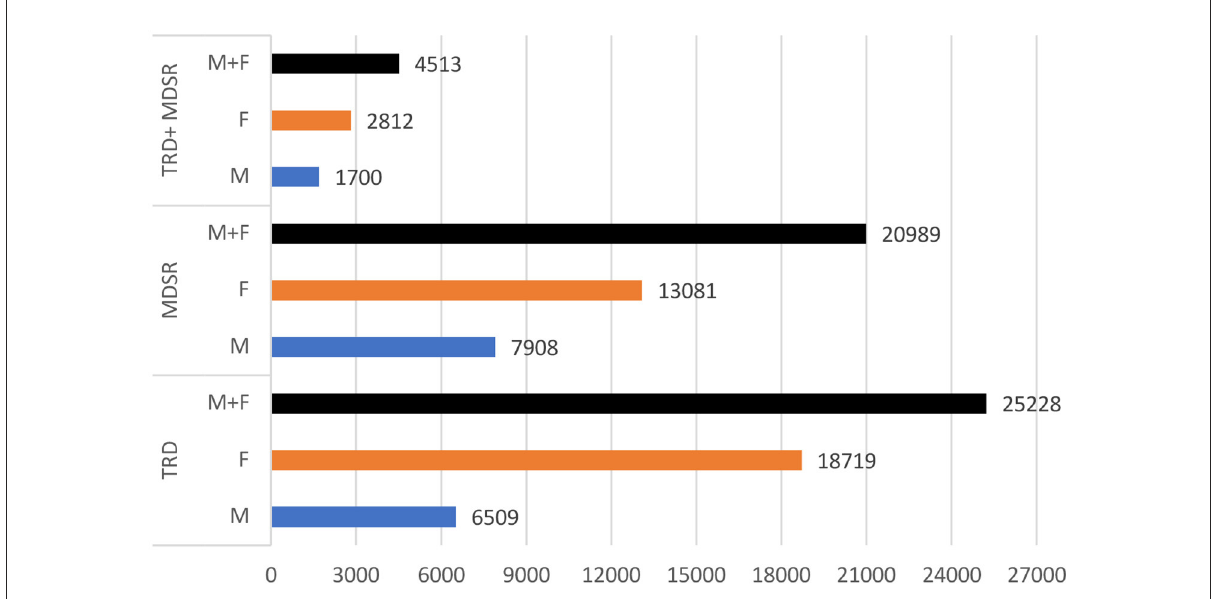
FIGURE1 Years lived with disability. TRD, Treatment-resistant depression; MDSR, Major depression with suicide risk; YLD, Years lived with disability; M, Male; F, Female; rounding to units.